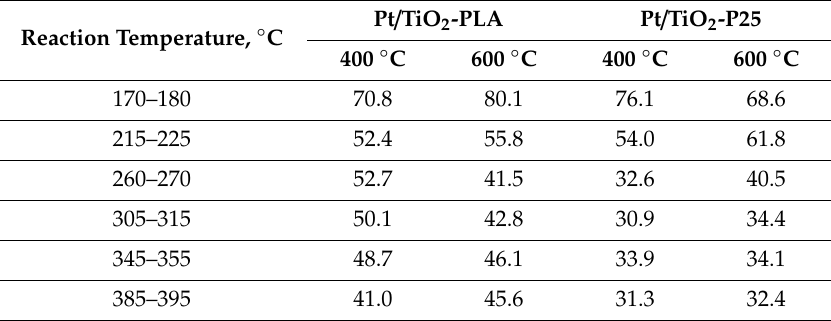
Table A3. N 2 selectivity at di ff erent temperatures for catalysts calcined 400 and 600 ◦